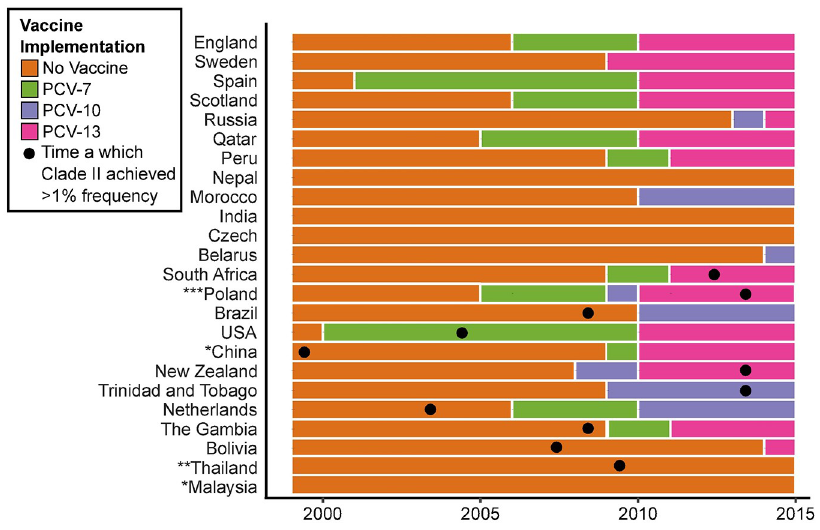
Fig 6. PCV implementation by country and year based on IVAC data from 1999–2014. For each country, the year is shaded based on PCV-7, PCV-10, and PCV-13 vaccine usage. Boxes marked with a dot designate the year in which a Clade II isolate was first observed. � Malaysia and China have yet to introduce PCV as part of their national immunization program. Pneumococcal vaccine use in China varies regionally. Data from China reflects PCV use in Hong Kong where serotype 3 isolates were sampled. �� PCV has been available in Thailand as an optional vaccine through the National Vaccine Program since 2006. However, uptake is < 5% in children under 5. ��� In Poland, PCV was available to parents through private pay. Population based vaccination, without catch-up campaign, was introduced in 2017 using PCV10.